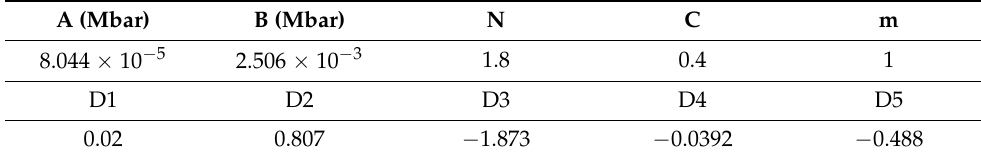
Table 2. Strength and failure model parameters for